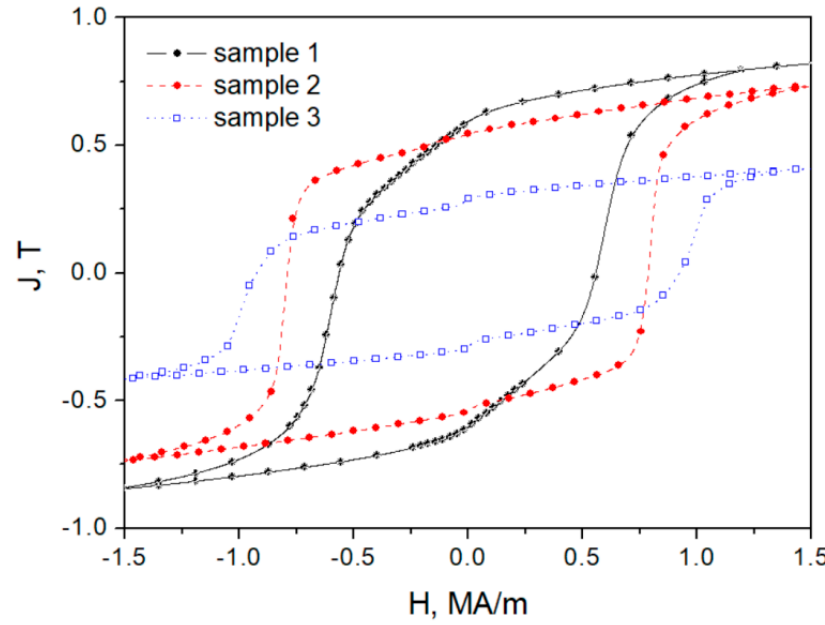
Figure 4. Measured hysteresis loops for annealed ribbons.